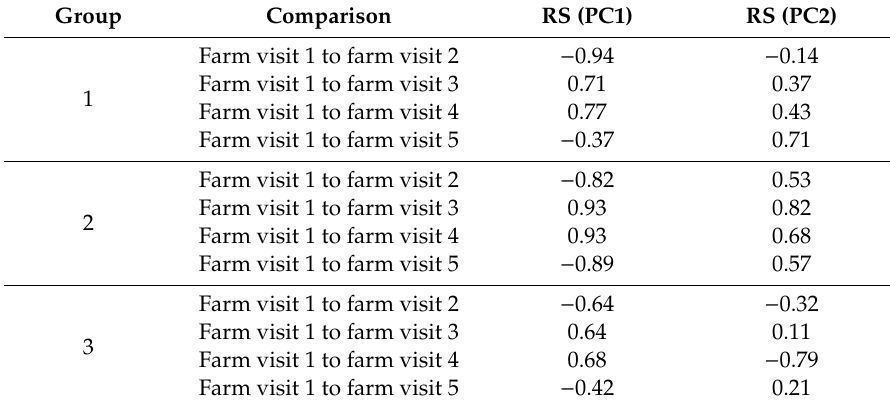
Table 5. Spearman’s rank correlation coe ffi cient (RS) for the comparison of the factor loadings on the first two principal components (PC; PC1 and PC2) between farm visits for the groups 1 determined by correlation between the adjectives of the Qualitative Behavior